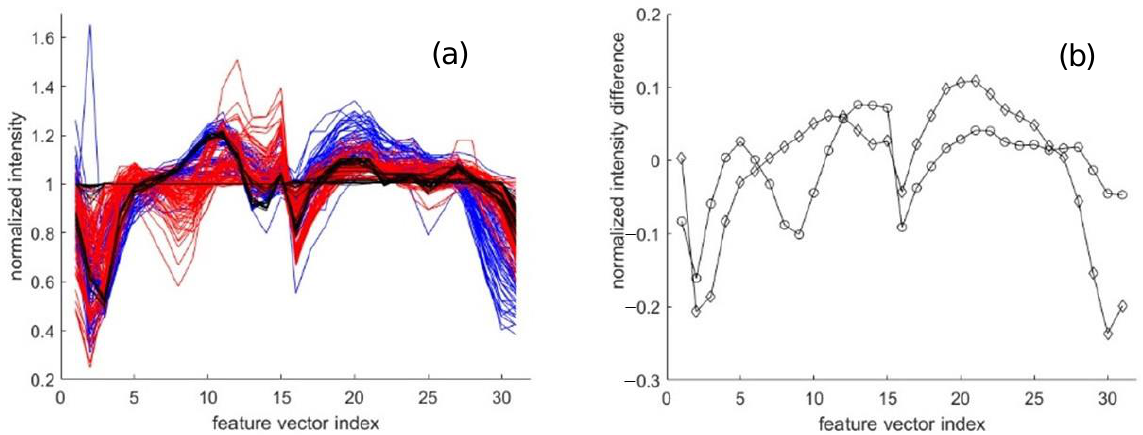
Figure 7. ( a ) Feature vectors of PET (blue), PE (red), and non-plastic samples (black) from the training set; ( b ) difference of the means of vectors from panel ( a ): Diamonds: (PET)- (non-plastics); circles: (PE)- (non-plastics).